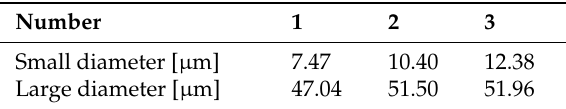
Table 1. Diameters of the three types of micro-tapered